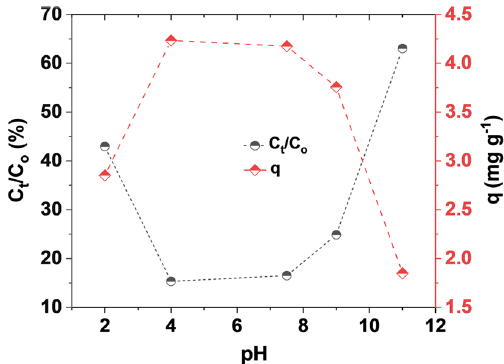
Fig. 7 The effect of pH for the adsorption capacity of L-Asp capped Fe 3 O 4 (1 mg mL −1 ) to 50 mL of RhB ( 5 mg L −1 ) at pH 7 and 25 °C